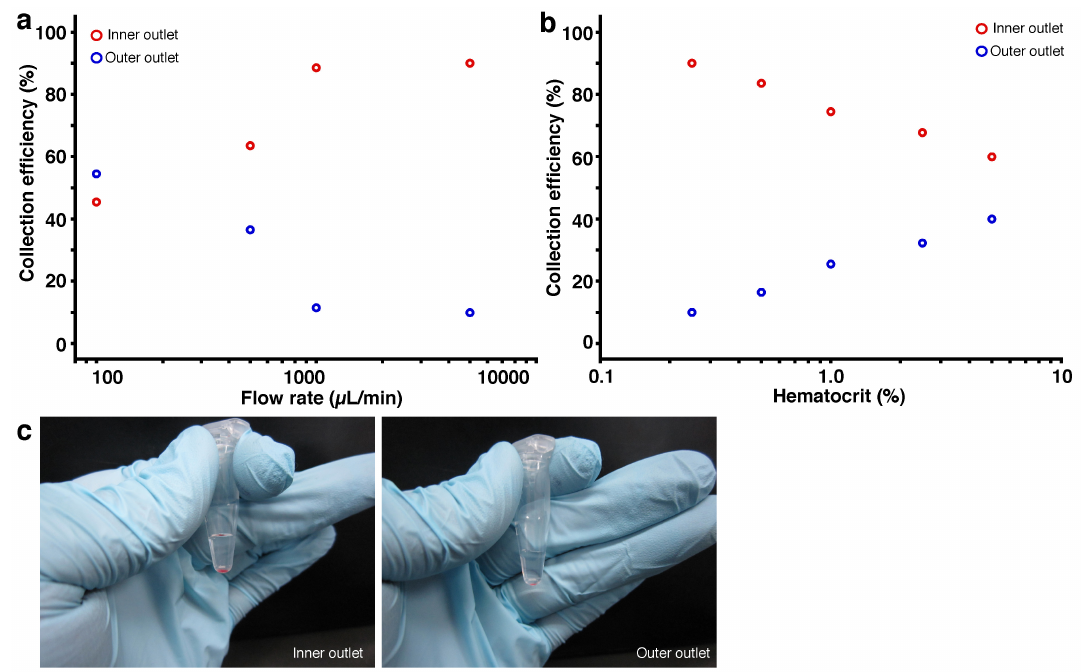
Figure 3. Collection efficiency of whole human blood cells. Cross-sectional area was 50,000 µ m 2 , the aspect ratio was 0.1, and the number of microchannel spirals was 7.5. ( a ) Collection efficiency vs. flow rate. Initial hematocrit of blood samples was 0.25%; ( b ) Collection efficiency vs. whole blood concentration. Flow rate was 5000 µ m/min; ( c ) Photographs of collected samples from inner and outer outlets after centrifugation. Flow rate was 5000 µ m/min, and initial hematocrit of blood samples was 0.25%. Hemolyzed blood was not observed.